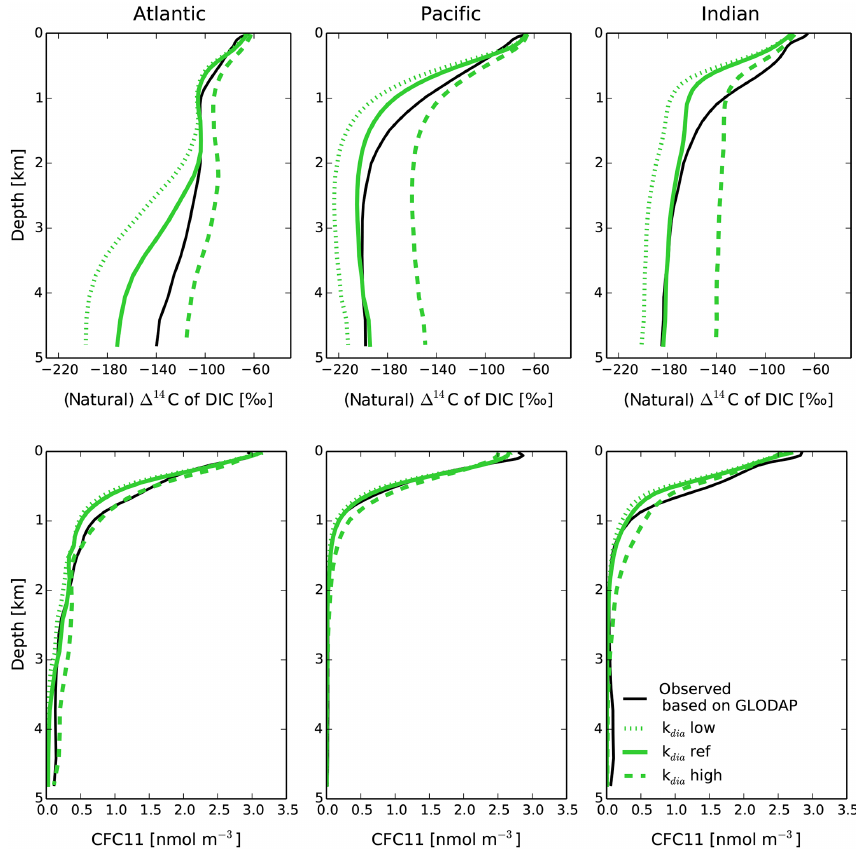
Figure A4. Basin-wide average profiles for (natural) (cid:49) 14 C of DIC (‰) at steady state (top) and for CFC11 (nmolm − 3 ) averaged over the model years 1990–2000 (bottom). Results are for simulations with a low (green dotted), standard (green solid), and high (green dashes) value of the diapycnal mixing coefficient k dia (0.1, 0.2 and 0 . 5 × 10 − 4 m 2 s − 1 ). Observation-based estimates are in black. The corresponding Southern Ocean sector is included in the averaging.